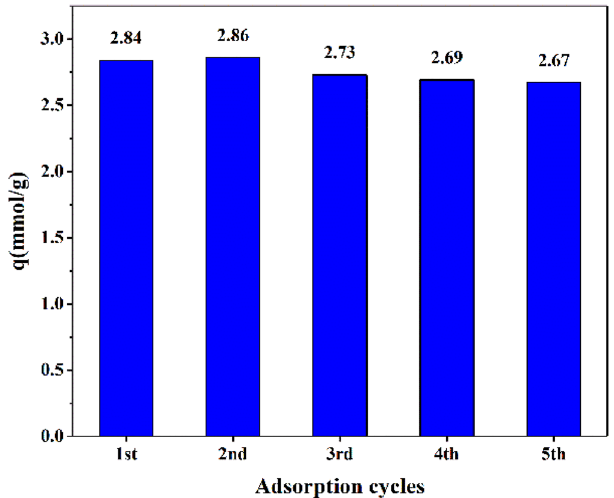
Figure 15. CO 2 PAN adsorption capacity in a number of adsorption–desorption